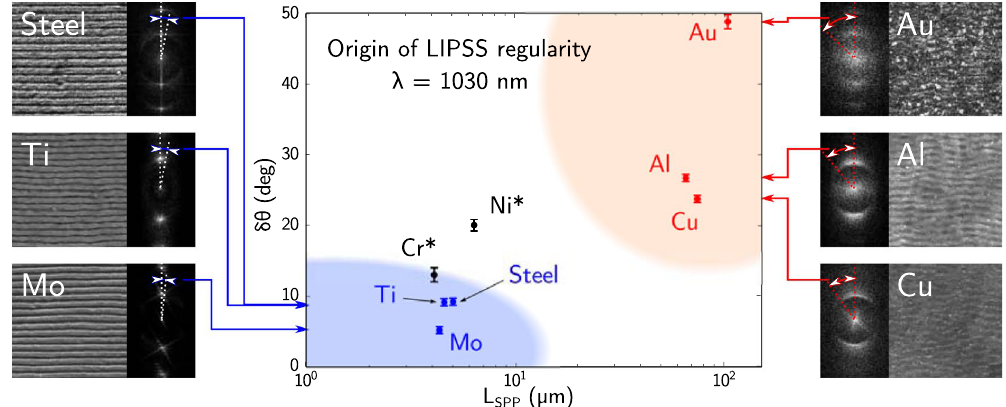
Figure 2. DLOA δθ as a function of the calculated mean free path L SPP of SEW. SEM images obtained with the same magnification are shown for metals studied in this paper (irradiation conditions are given in Table 1) with the corresponding 2D-FT images. Note that the angular sizes displayed on the 2D-FT are comparable to but not as precise as the DLOA used here. Asterisks stand for DLOA δθ data for Cr and Ni, estimated from the images of refs 15 and 26 respectively. Vertical error bars were evaluated from the convergence of the DLOA δθ (see Materials and Methods). The LIPSS fabricated in this work, which exhibit high and low regularities, are marked respectively by blue and pink. Materials located in the blue-colored area (respectively in pink-colored area) are suitable (respectively non-suitable) for the HR-LIPSS